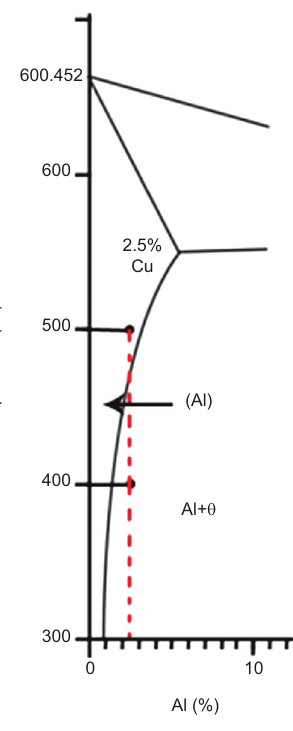
Figure 10 Al-rich side of the Al-Cu phase